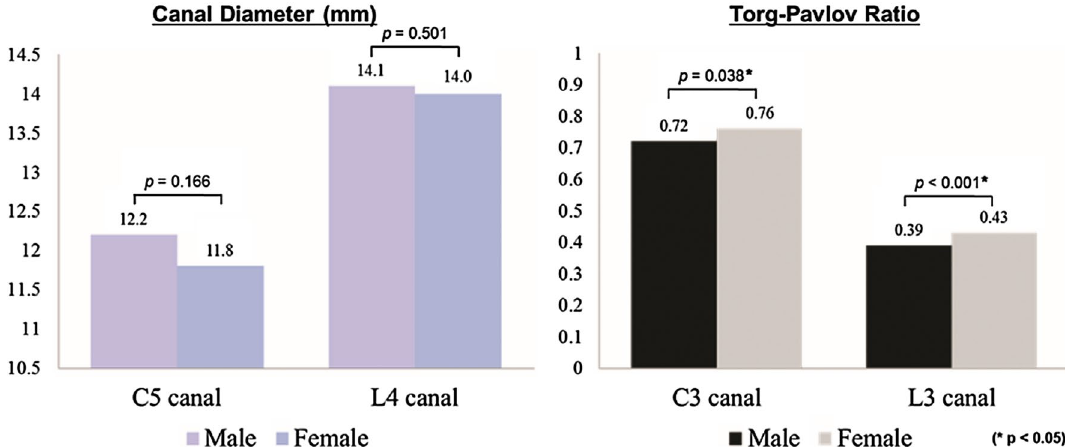
Figure 2. Comparisons of canal diameter and spinal canal to body ratio between male and female patients. There were significant differences in the canal to body ratios between male and female patients ( p < 0.05, right graph), but not in canal diameters ( p > 0.05, left graph).